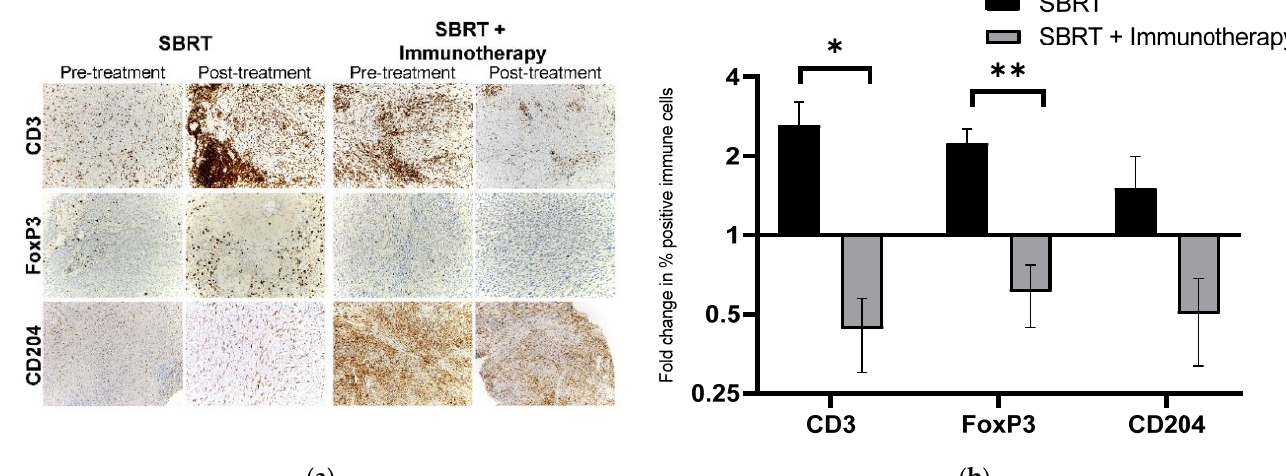
Figure 2. Tumor immune infiltrates associated with SBRT and SBRT + immunotherapy: ( a ) representative IHC images of immune cell infiltrates, pre-treatment and post-treatment, for tumors treated with SBRT or SBRT + immunotherapy; ( b ) fold change in percent positive immune cell density post-treatment relative to pre-treatment for tumors treated with SBRT or SBRT + immunotherapy. * p = 0.025, ** p = 0.008 (SBRT: n = 4; SBRT and immunotherapy: n = 3).